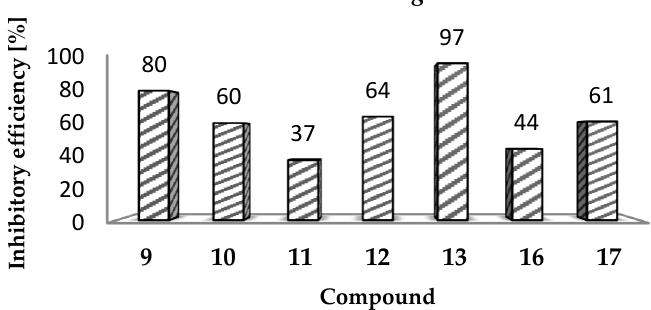
Figure 5. Comparison of the inhibitory activity of imidazolone derivatives towards AcrAB-TolC efflux pump in E. aerogenes Ea-289 strain.